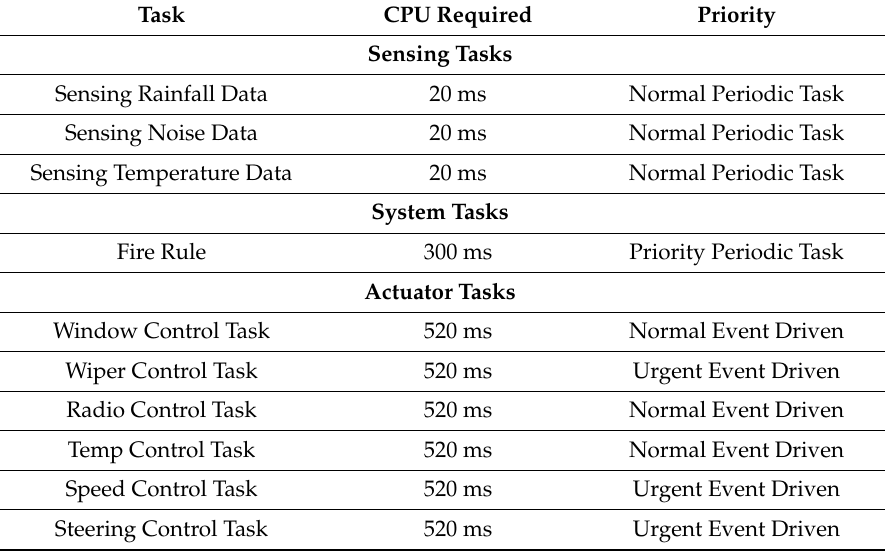
Figure 10. Implementation flow of scheduling and inference engine. Table 7. Example derived scenario for rainfall, noise and